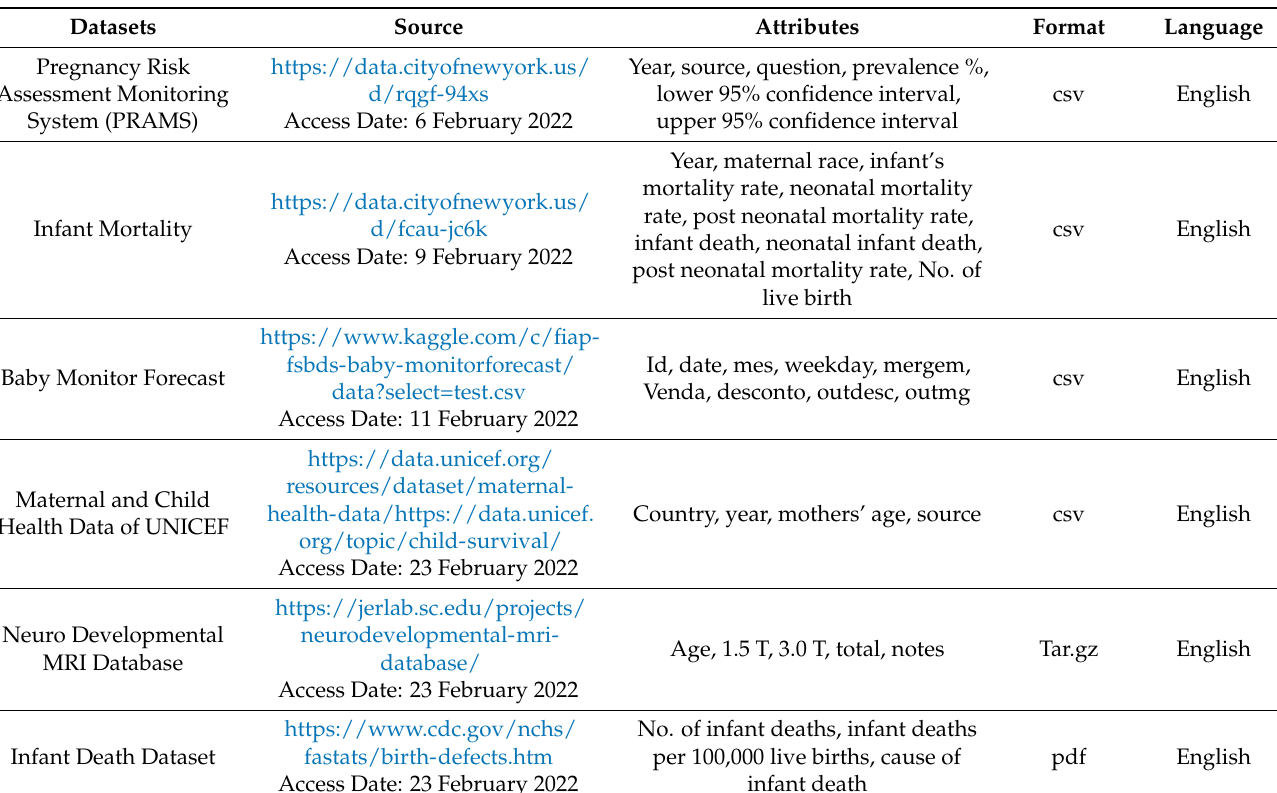
Table 6. Summary of publicly available